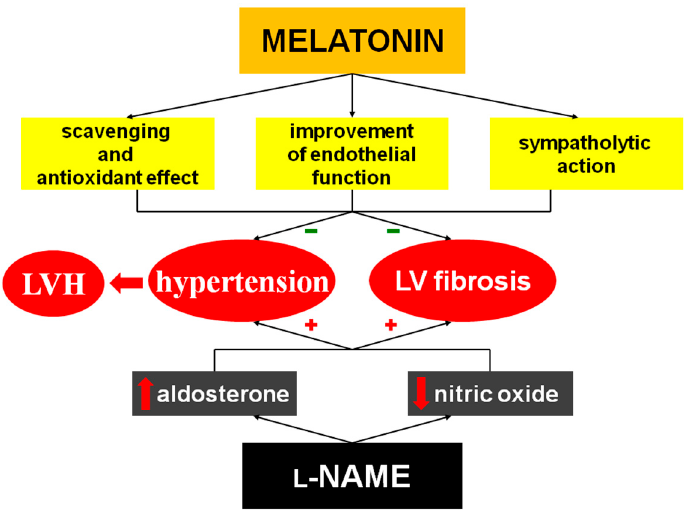
Figure 7. Potential mechanisms of protective effect of melatonin in L -NAME-induced hypertension. Chronic L -NAME administration induces hypertension development, fibrosis of the left ventricle (LV) and via increased hemodynamic load left ventricular hypertrophy (LVH) develops. Melatonin reduces free radical burden by its antioxidant and scavenging effect, improves endothelial function and exerts central sympatholytic effect. These actions of melatonin reduce hypertension development and fibrosis in the LV. Since the effect of melatonin on blood pressure is only mild, LVH remains unaffected.